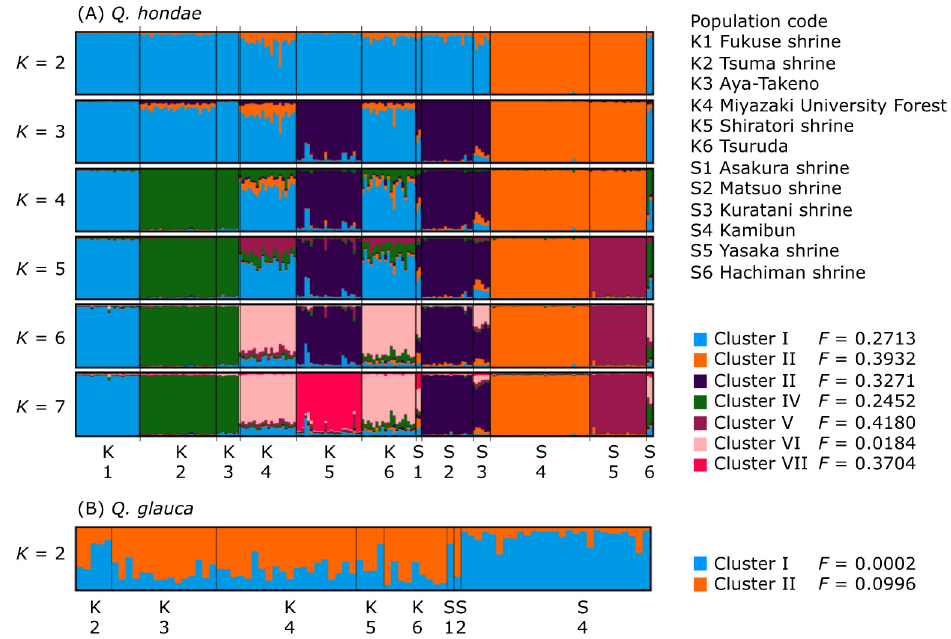
Figure 3. STRUCTURE bar plots of individuals with K = 2–7 for Q. hondae ( A ) and K = 2 for Q. glauca ( B ). Populations were separated by black bars. The neighbor-joining tree of populations of Q. hondae based on Nei’s D A distance was generally consistent with the STRUCTURE analysis (Figure 4). The populations assigned tree, whereas the populations from Kyushu were grouped together and only the Shiratori not statistically supported).